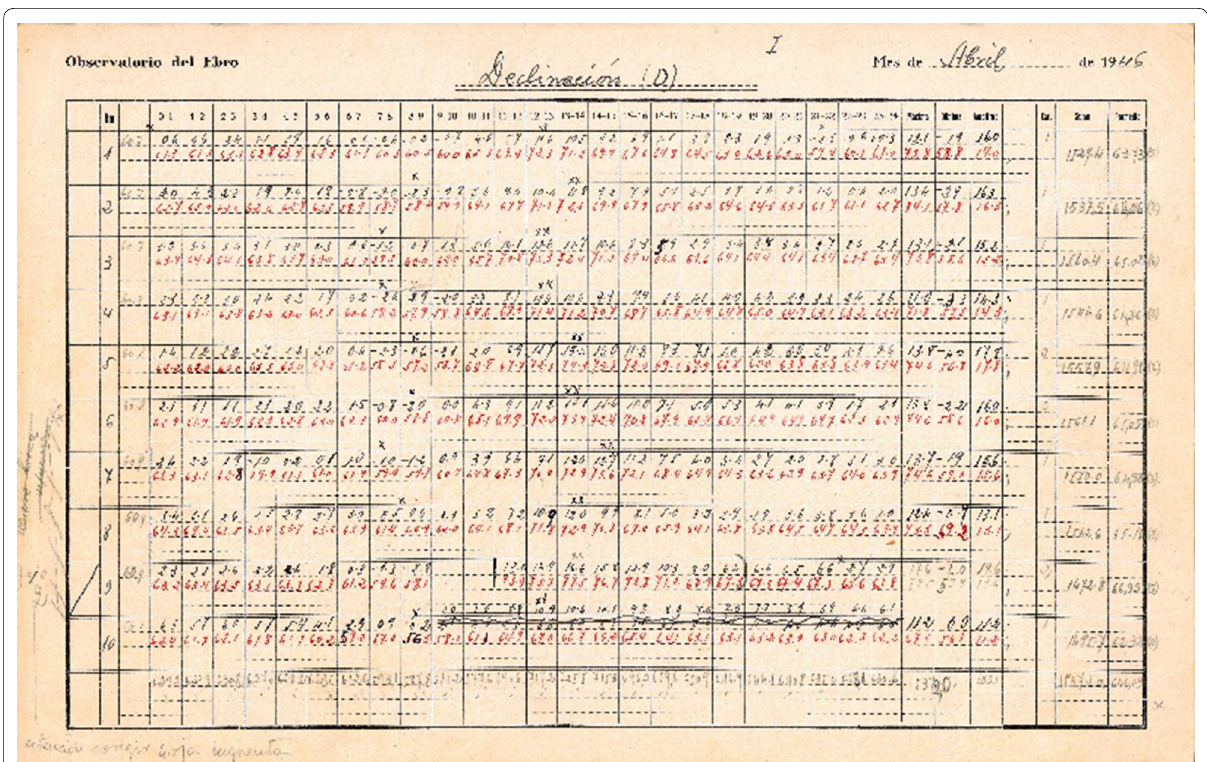
Fig. 16 Copy of the table sheet with the conversion from mm into minutes of arc for Ebro D component in April